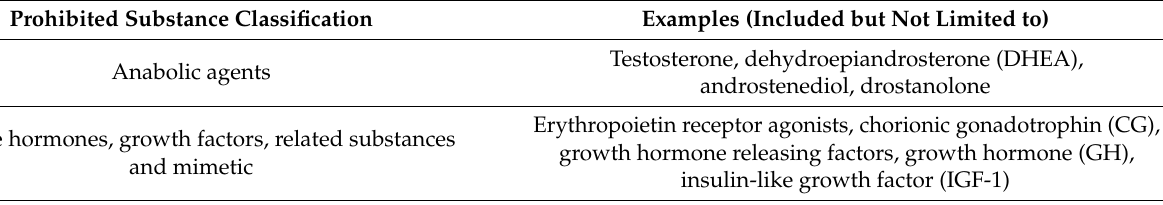
Table 1. WADA’s Classification of prohibited substances, with examples